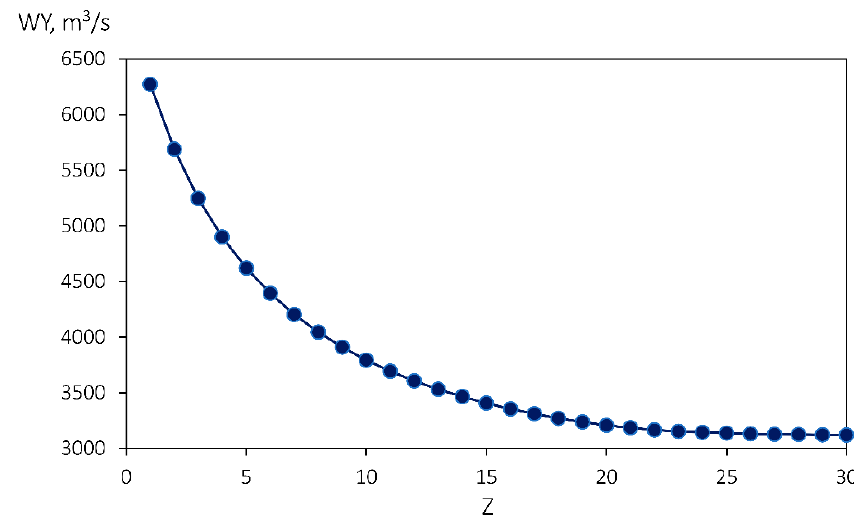
Figure 4. Water yield (WY) variation using different Zhang coefficient ( Z ). Model Sensitivity to Kc